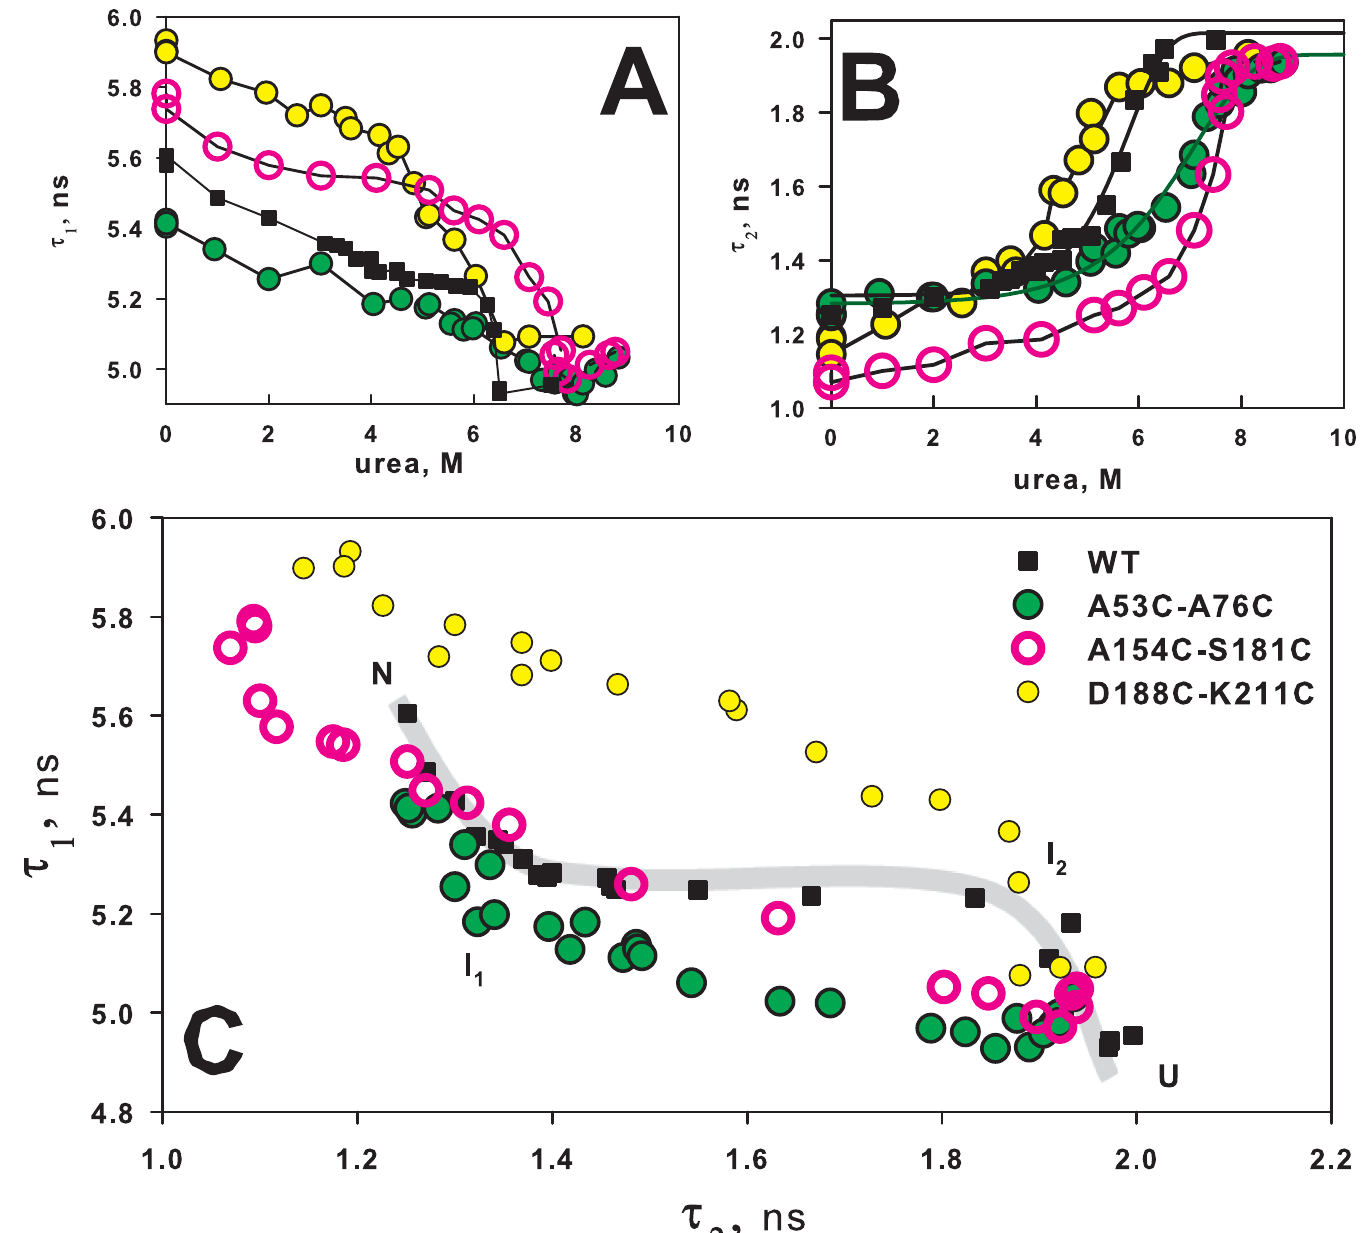
Fig 7. Effect of inserted disulfide bridge on BCA II unfolding. Dependence of fluorescence lifetimes τ 1 (A) and τ 2 (B) on urea concentration of wild-type BCA II ( ■ WT) and its three mutant forms with disulfide bridge A53C-A76C ( ● ), A154C-S181C ( � ) and D188C-K211C ( ● ). (C)–interdependence of two fluorescence lifetime components τ 1 and τ 2 of wild-type BCA II and its three mutant forms with inserted disulfide bridge. The relative deviations for τ 1 and τ 2 were � 3% and � 7% correspondingly.